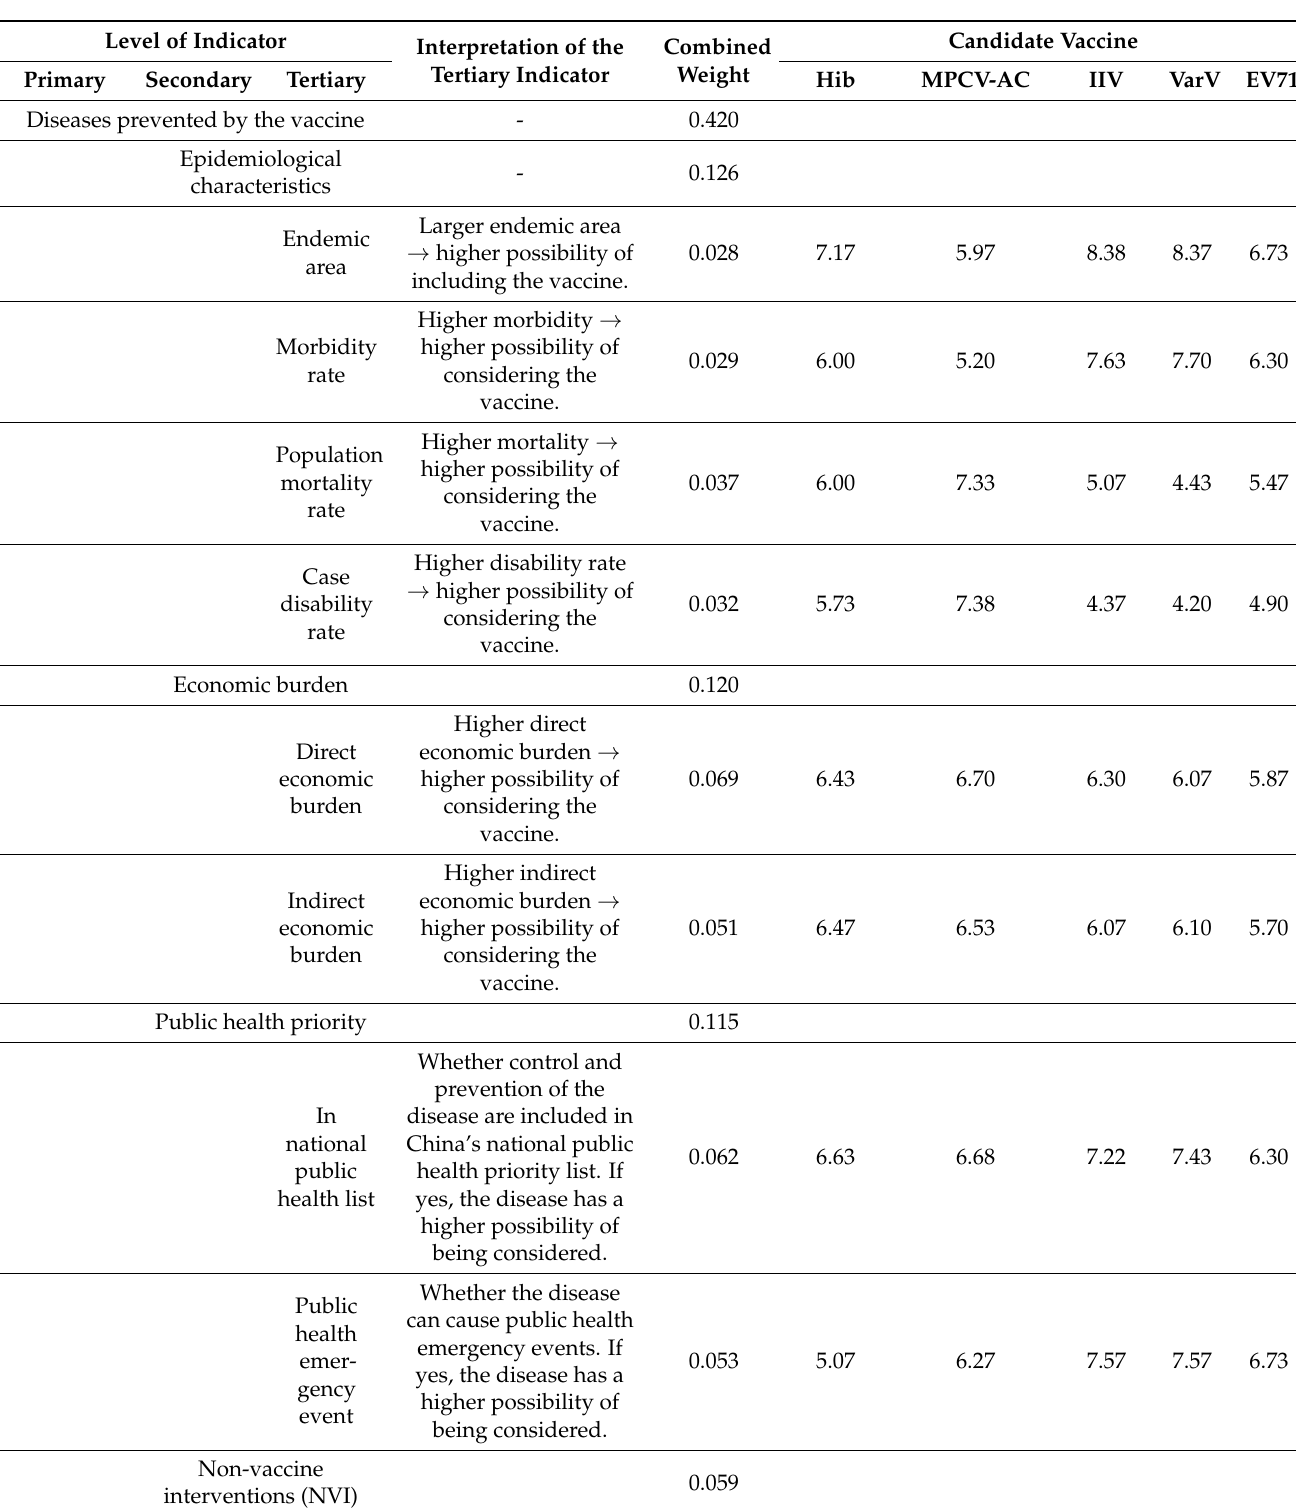
Table 4. Indicator system and Delphi results for vaccine inclusion into